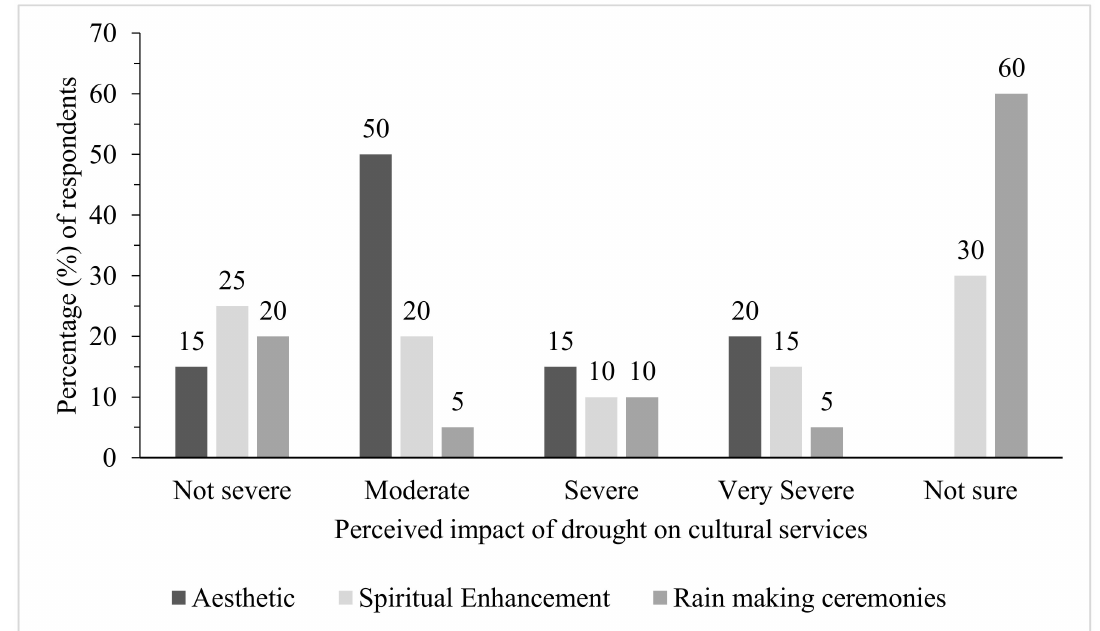
Figure 7. Perceived impact of drought on wetland cultural